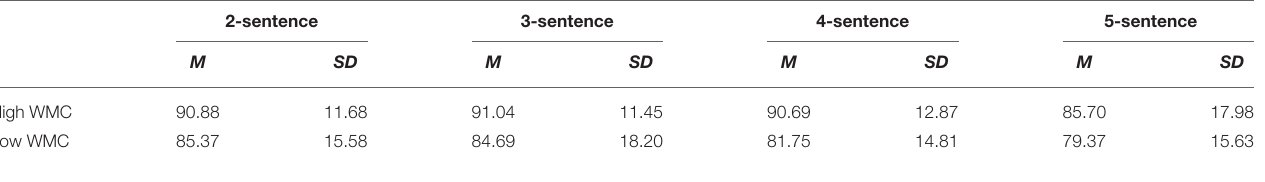
TABLE 5 | Mean confidence in correct word recall in each memory load condition for high and low WMC